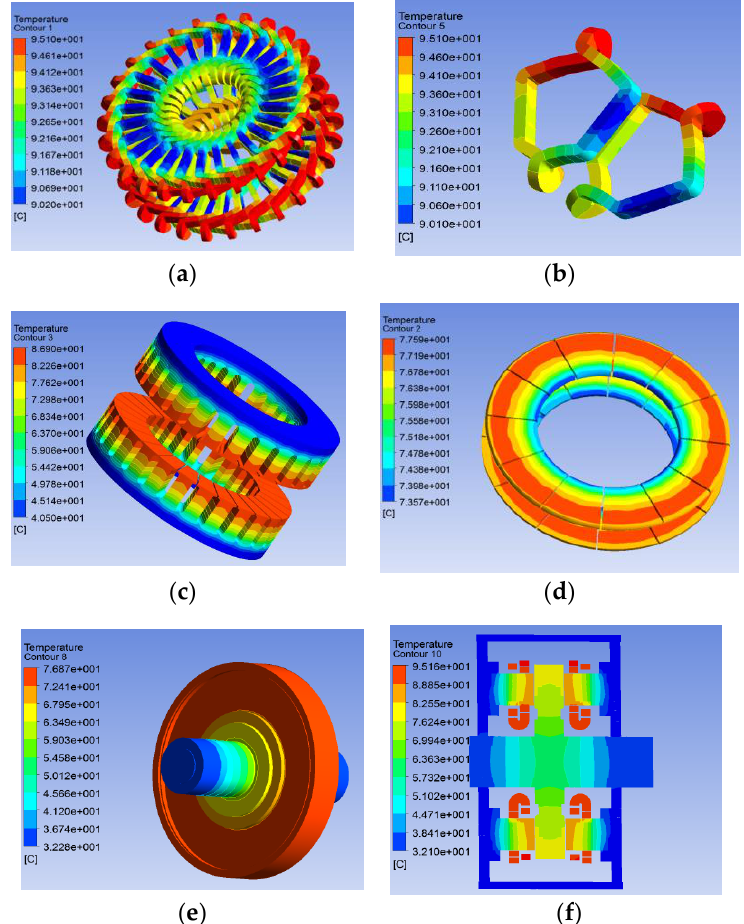
Figure 28. Temperature map of each part of the AFPMSM. ( a ) Winding temperature cloud map. ( b ) Upper and lower winding temperature cloud map. ( c ) Stator core temperature cloud map. ( d ) Permanent magnet temperature map. ( e ) Rotor and shaft temperature cloud map. ( f )Whole machine section temperature cloud map.